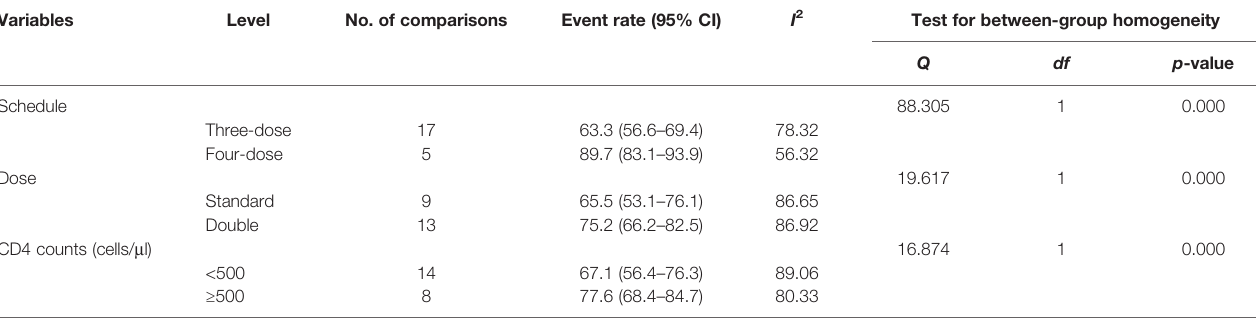
TABLE 2 | Meta-analysis results assessing the ef fi cacy of HBV vaccination in response rates across subgroups. Variables